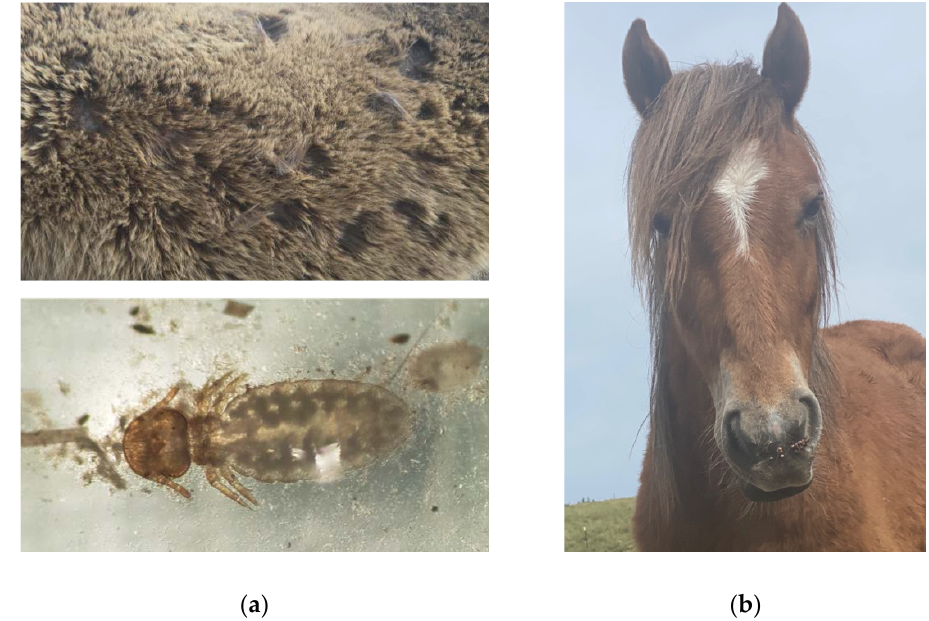
Figure 8. Examples of skin lesions caused by infectious diseases. ( a ) Skin lesions (upper image) caused by the louse Damalinia equi (lower image). ( b ) Warts on the nose caused by Papillomavirus. Images A. M. Harvey.